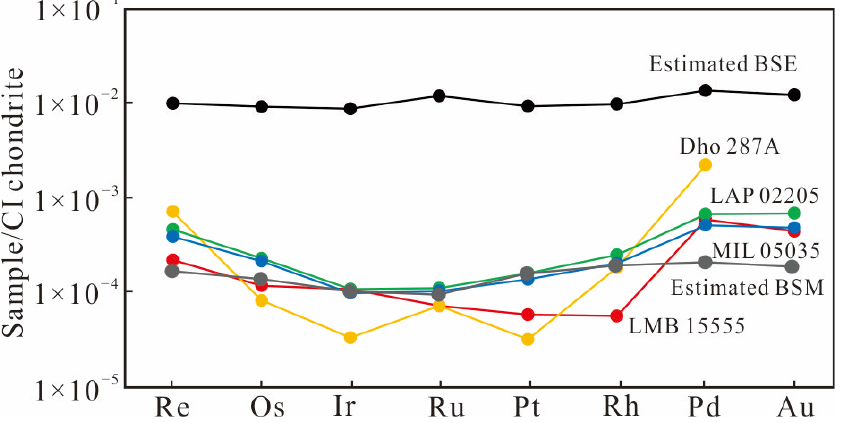
Figure 5. Estimated Os, Ir, Ru, Pt, Pd, Re abundances in the BSE and BSM. HSEs of both the BSE and BSM are roughly chondritic, ~0.008 × CI chondrite of the BSE and ~0.0002 × CI chondrite of the BSM. Data of the BSE and BSM were collected from [54,60]. Dho 287A, LAP 02205, MIL 05035, and LMB 15556 are lunar samples reported by [64]. Chondrite normalization follows [65].